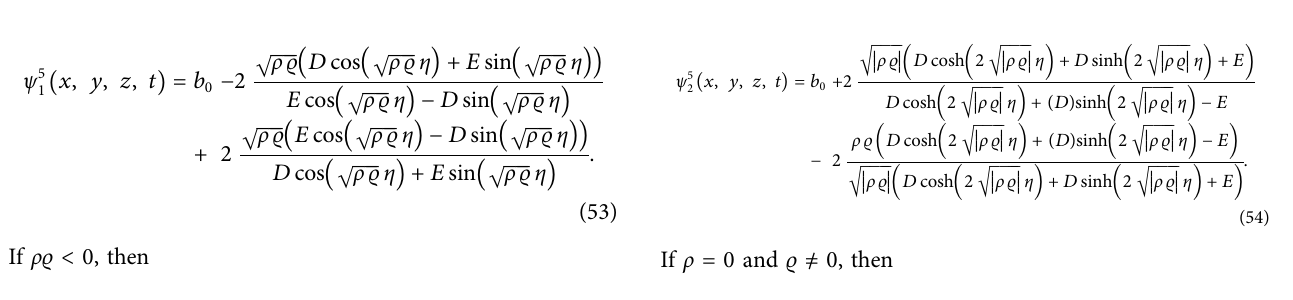
FIGURE 5 | ψ 4 1 ( x , y , z , t ) : κ = 2, D = 6, rest of constants = 1 .